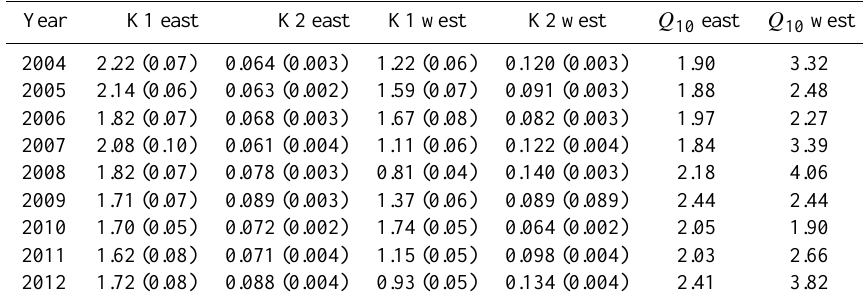
Figure 4. Monthly estimated R eco for the east sector (blue solid line with open circles) and west sector (green solid line with open circles) for (a) 2006, (b) 2009 and (c) 2012; monthly mean air temperature (at 26m height) and monthly precipitation total for (d) 2006, (e) 2009 and (f) 2012; modelled temperature response ( R s derived from night-time NEE fluxes only) for east sector (blue sold line) and west sector (green solid line) for (g) 2006, (h) 2009 and (i) 2012 (error bars represent 95% confidence intervals) at the Straits Inclosure, Alice Holt Forest. Table 3. Night-time ecosystem respiration ( R s ) coefficients and the estimated Q 10 values (base temperature: 0 ◦ C) derived from fitting an exponential equation to half-hourly night-time NEE and air temperature values over the period 2004–2012 at the Straits Inclosure, Alice Holt